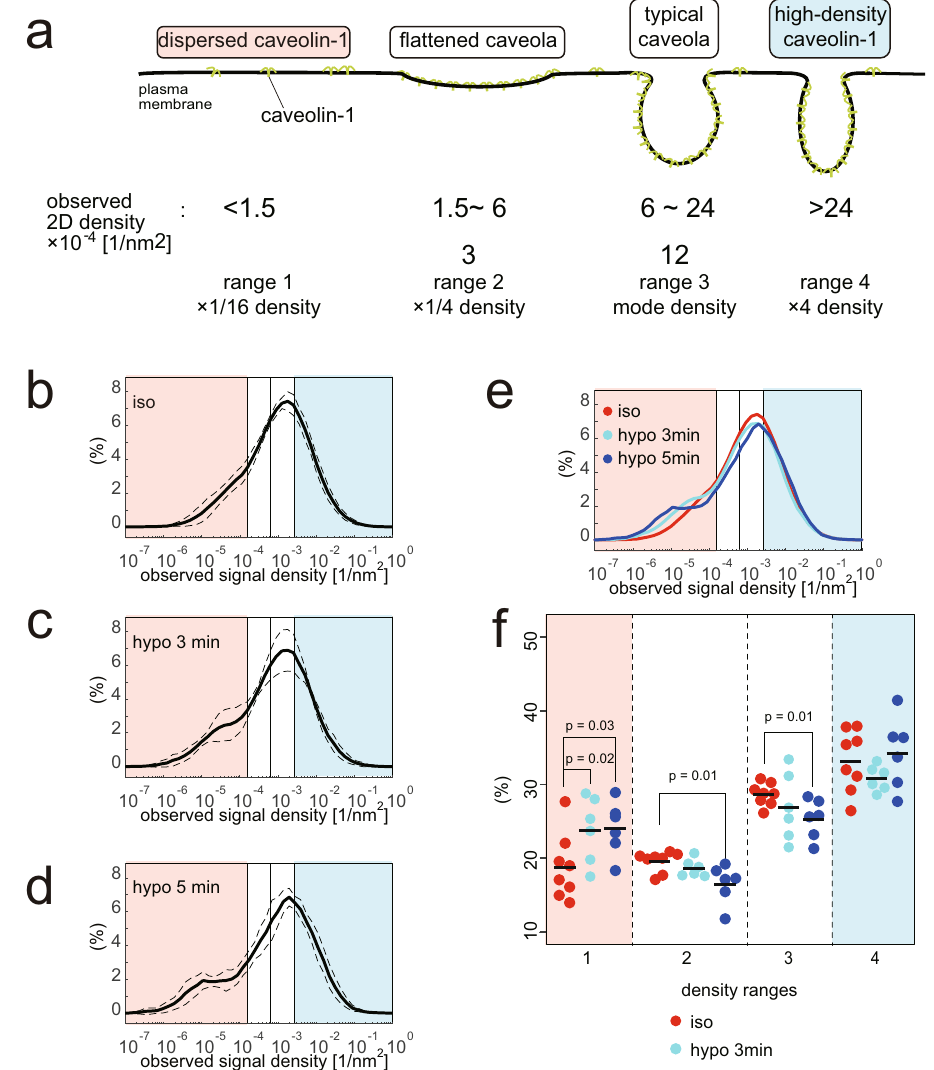
Figure 3. Local density estimation from STORM signals of caveolin-1. ( a ) A schematic representation of caveolin-1 density and expected shapes of caveolae by a 4-times density scale. Under isotonic conditions, typical caveolae had a mode density of 12 × 10 − 4 /nm 2 and flattened caveolae were expected to have a density of 3 × 10 − 4 /nm 2 . Therefore, we analysed the percentages of caveolin-1 molecules by densities ranging from 1.5 to 6 and from 6 to 24 × 10 − 4 /nm 2 as “flattened” and “typical” caveolae, respectively. The percentages of caveolin-1 below 1.5 (dispersed caveolin-1) and above 24 (high-density caveolin) were also analysed. ( b – e ) The average density distributions of the STORM signals by the 4 th NND in cells treated with ( b ) isotonic culture medium, ( c ) hypotonic conditions for 3 min and ( d ) hypotonic conditions for 5 min. The distribution of each cell was analysed using relative densities to the mode density and then plotted using the averaged mode. The dashed line indicates the standard deviation. The density ranges in ( a ) are also indicated by colour. In ( e ), the superposition of ( b – d ) is shown. ( f ) Percentages of caveolin-1 by the density ranges as in ( a ) in each cell. The average percentages (black bars) between cells in isotonic medium and hypotonic treatments for 3 and 5 min were significantly different. Indicated p-values were obtained using the Student’s